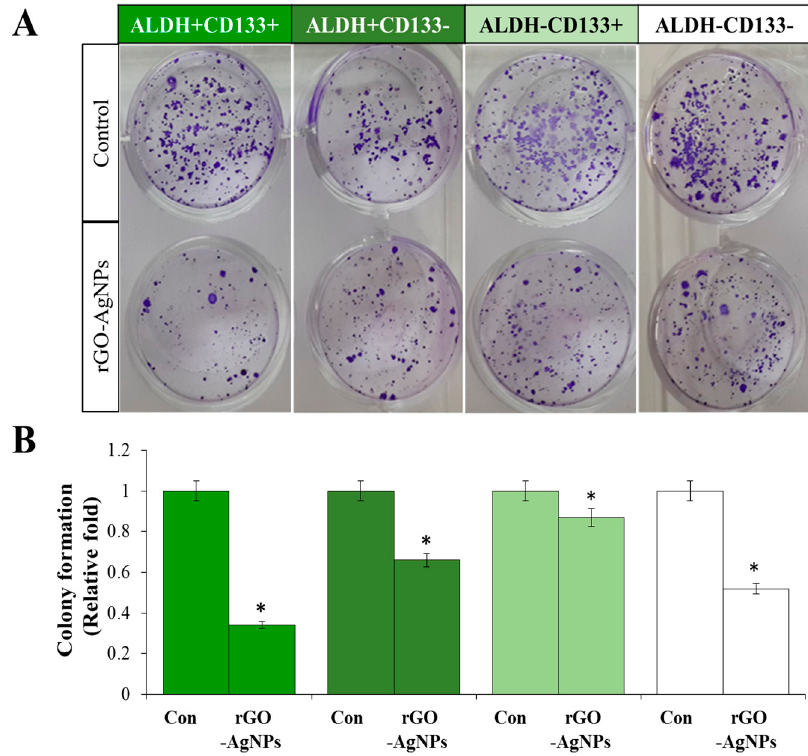
Figure 5. Effect of rGO–Ag on clonogenicity of various subpopulations of OvCSCs. Colony formation was quantitatively analyzed by crystal violet staining ( A ), the crystal violet was dissolved in methanol and then the absorbance was measured at 590 nm, (* p < 0.05) ( B ).